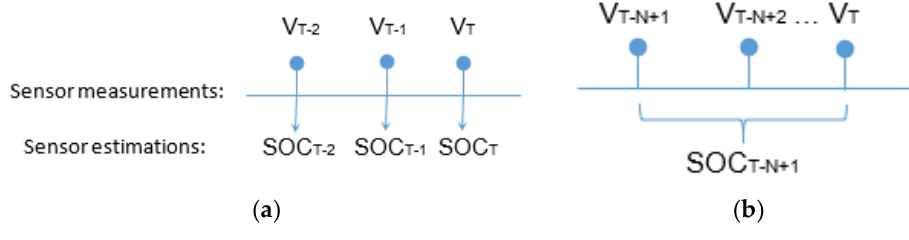
12 of 24 Figure 4. Flowchart of the optimal projection method for solving diffusion PDEs. 5. Moving-Window Filter for Electrochemical SOC Estimation Conventional state filtering methods such as the Kalman filter are sequential estimation algorithms which utilize the measurements at a single time point to provide the state estimation. Figure 5a shows a schematic plot for conventional sequential state filters. As mentioned earlier, the conventional approaches are computationally efficient, however, they may converge very slowly and may not be robust to outliers in the measurement. Therefore, this Section develops a new state filter algorithm based on the moving window to ensure the fast convergence of the proposed electrochemical SOC estimation model. In this method, more data points are used for estimation of